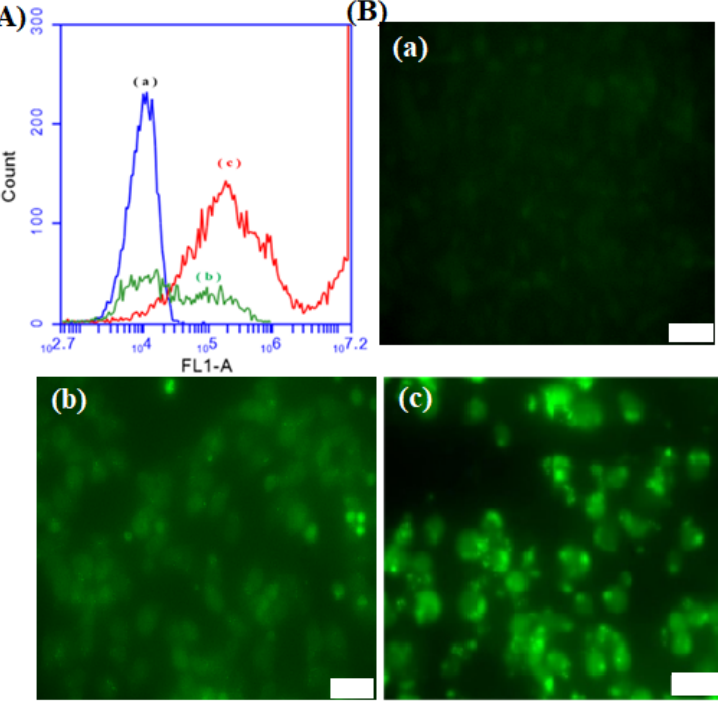
Figure 12. ( A ) Flow cytometry and ( B ) fluorescence microscopy of DCFDA assay to determine ROS in MES-SA/Dx5 cancer cells of (a) control; (b) IBN-1-Cur-CP, and (c) IBN-1-Cur-CP sample with light irradiation at the nanoparticle concentration of (50 μ g/mL).